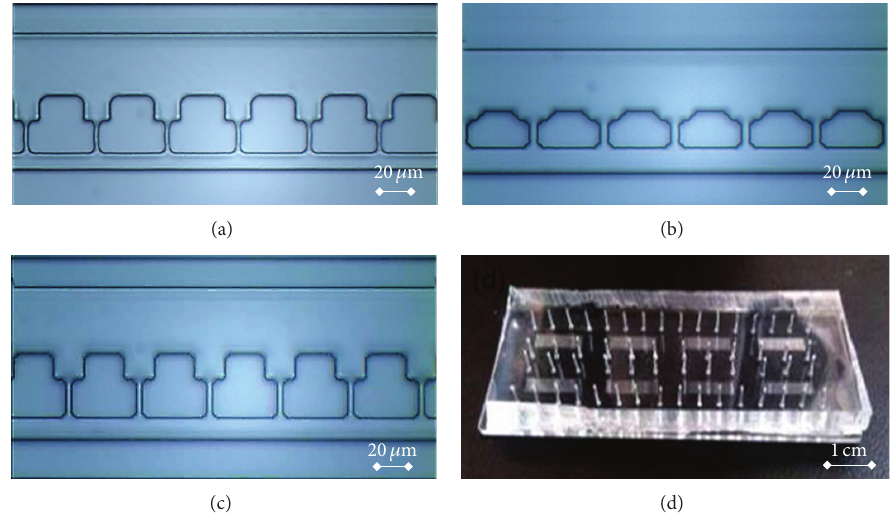
Figure 3: Microfluidic device fabrication results. (a) At an exposure time of 2.5 sec, channel distortion was located as an indicator of underexposure. (b) At an exposure time of 3.5 sec, channel enlargement was noticed as a sign of overexposure. (c) Exposure time of 3.0 sec produced nice device features as the optimal exposure time. (d) A fabricated prototype device.